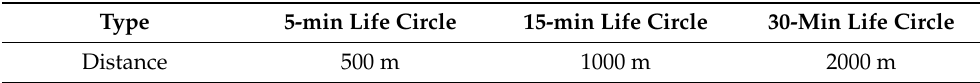
Table 3. Traveling